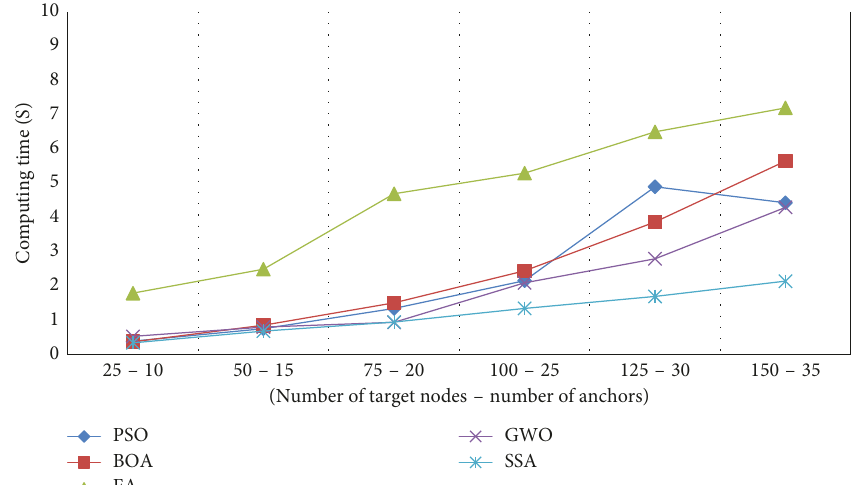
Figure 5: The computing time of the different localization algorithms in different WSN deployments.